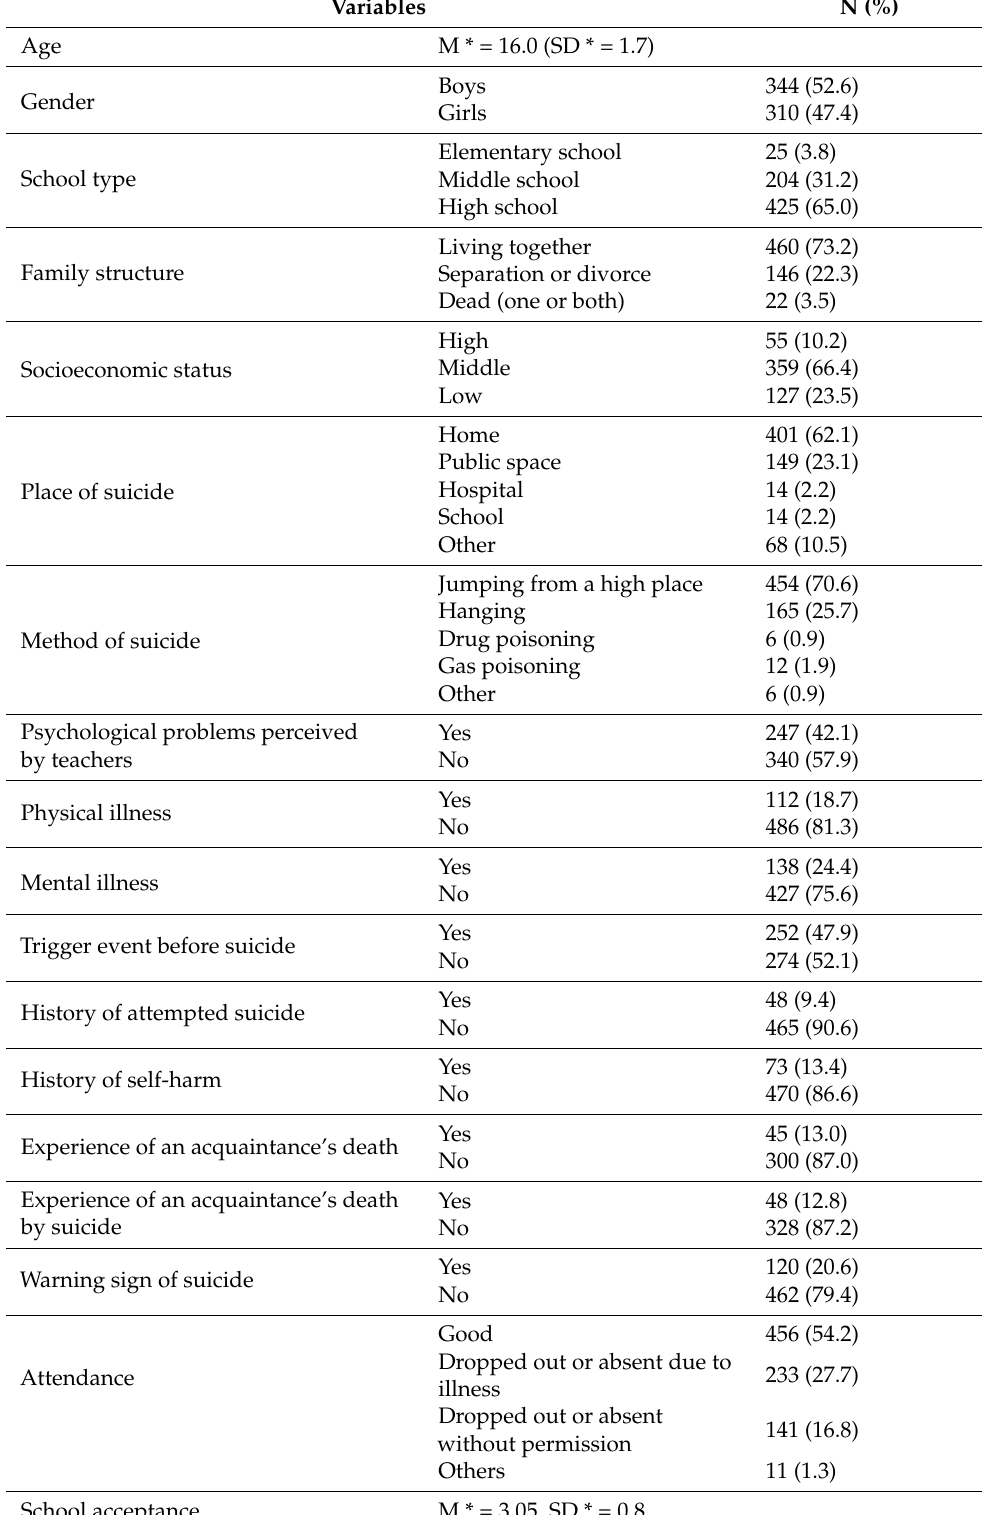
Table 1. Sociodemographic characteristics of students who died by suicide in 2016–2020 (N =